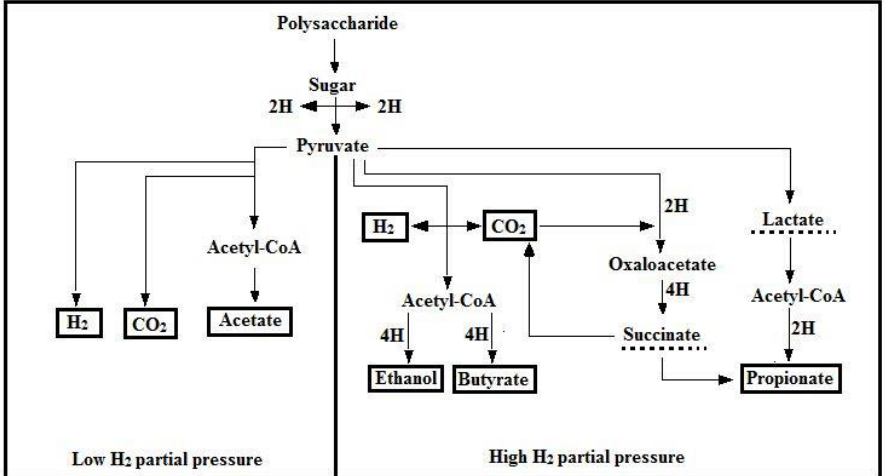
Figure 1. Metabolic pathway of H 2 formation.